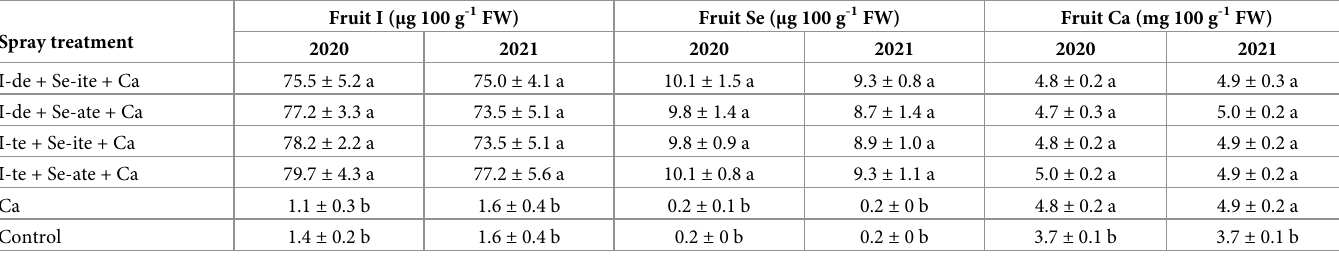
Table 5. Effects of combined sprays of iodine (I), selenium (Se) and calcium (Ca) on the amounts of those nutrients in edible parts of ‘Red Jonaprince’ apples at harvest. Spray